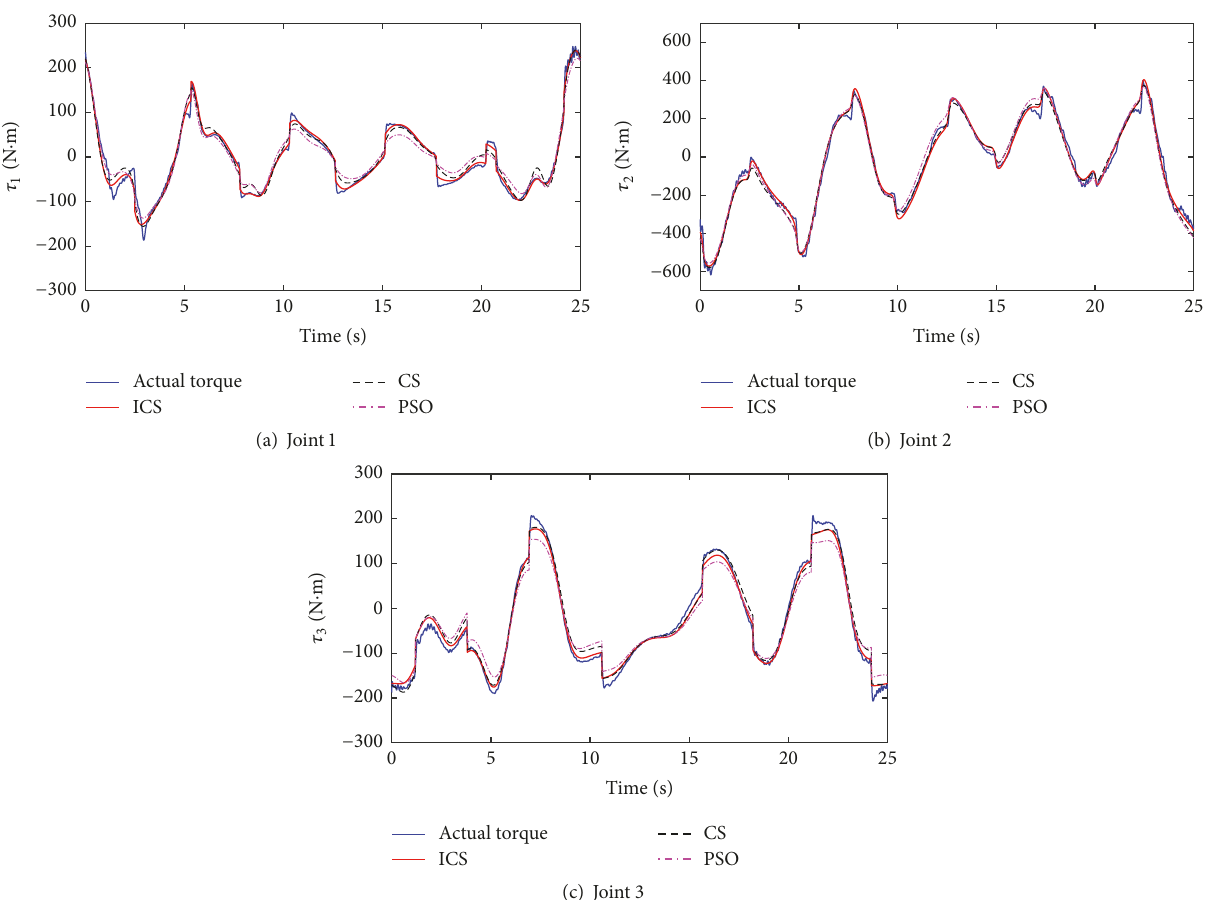
Figure 6: Comparison of the measured torques and predicted torques.